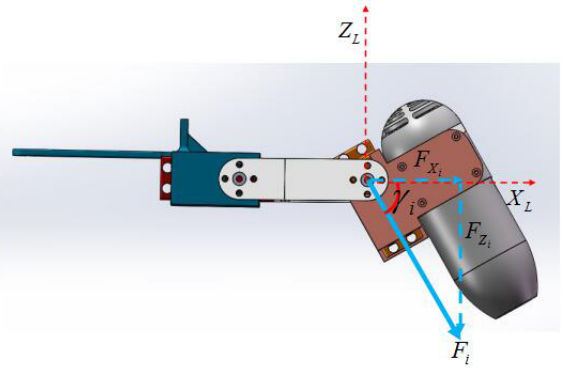
Figure 5. Definition of γ i